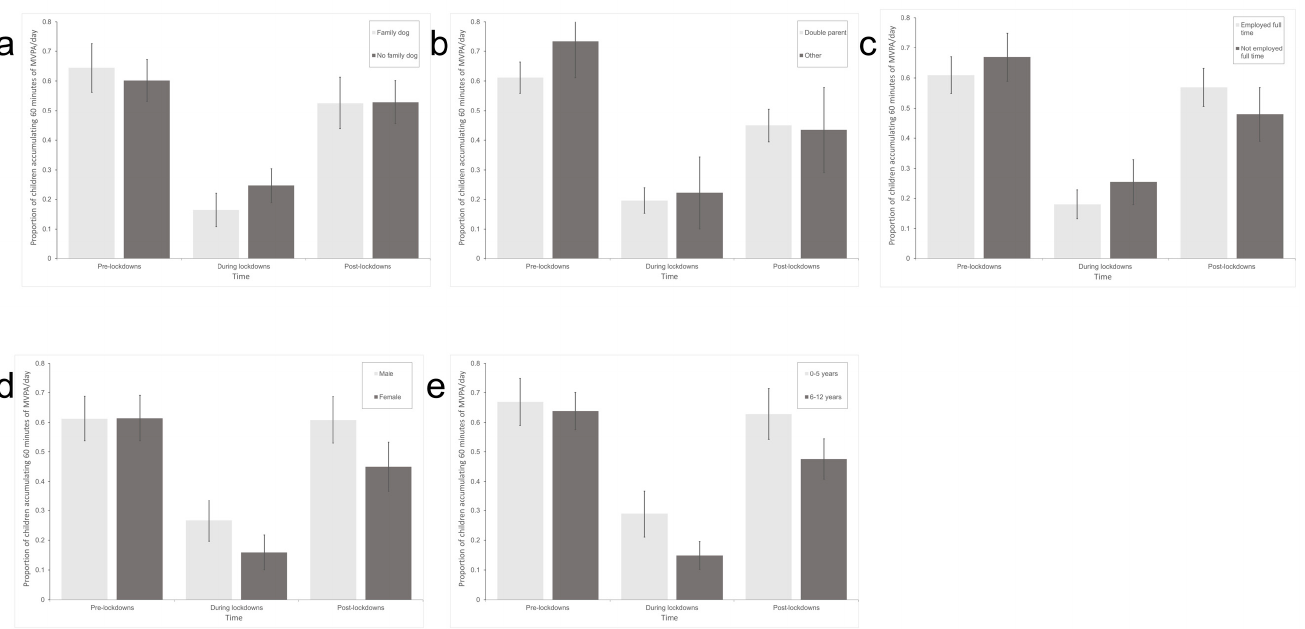
Figure 3. Difference in the proportion of children attaining 60 minutes of physical activity, as reported by parents, pre-lockdown, during lockdowns, and post- lockdown based on a) owning a family dog, b) family situation, c) parent employment stats, d) child sex, and e) child age.